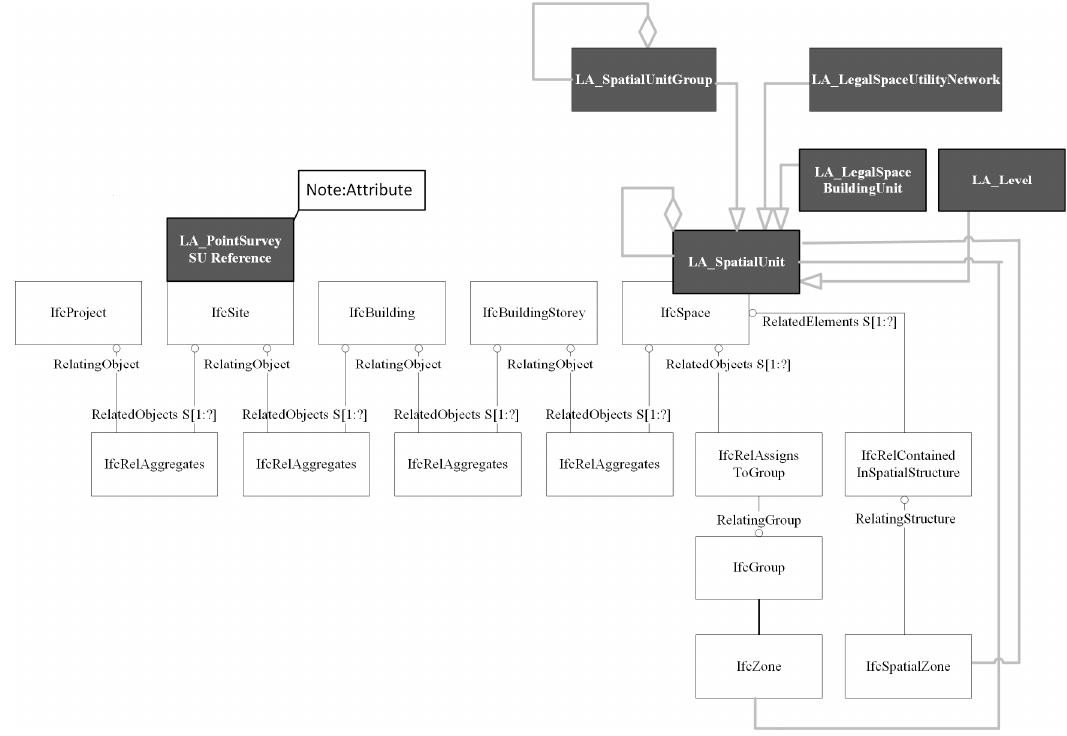
Figure 4. Mapping between the LADM and the IFC: Decomposition.